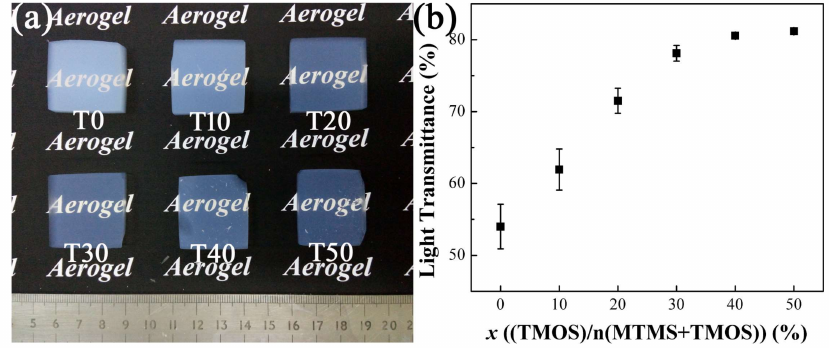
Figure 4. Photographs of the monolithic aerogels ( a ) and the light transmittance at 550 nm wavelength ( b ).